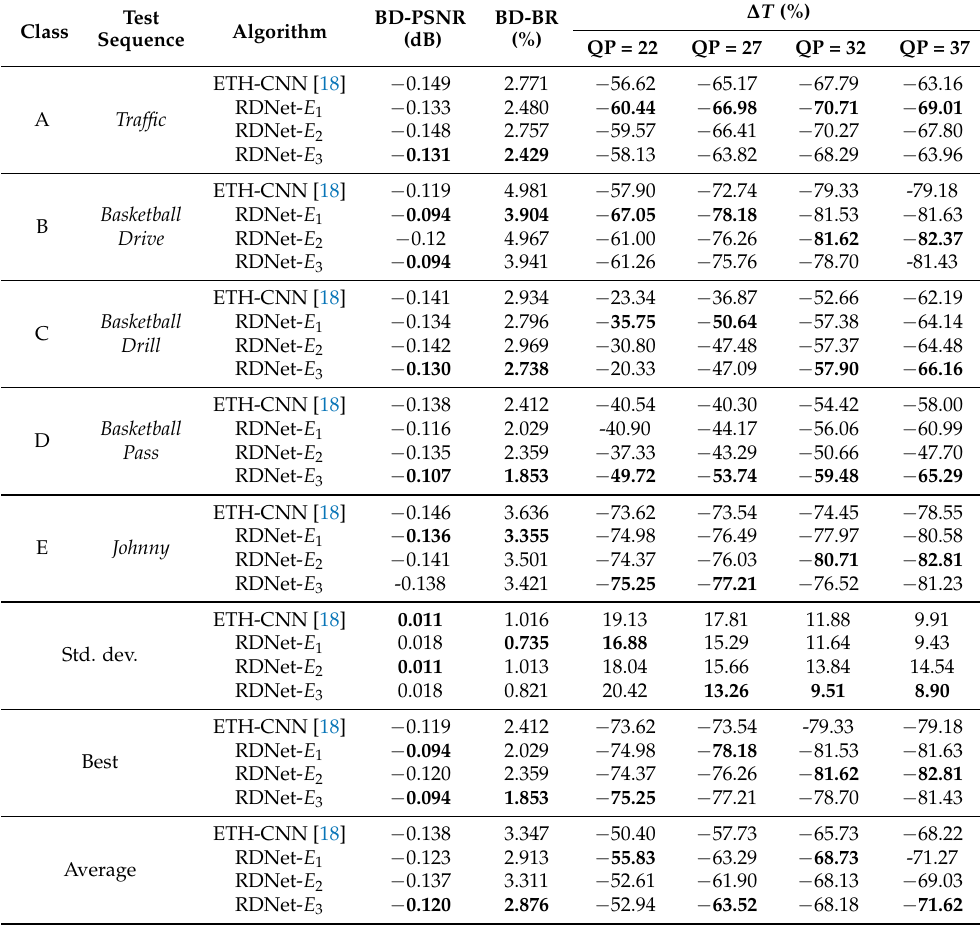
Table 3. The ablation study results of JCT-VC test set